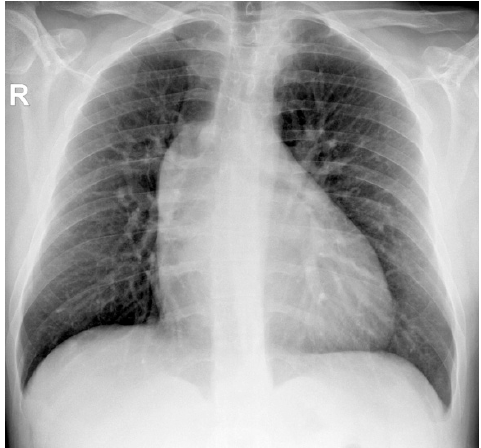
Figure 2. Thoracic radiography (AP projection)—widening of the middle mediastinum on the right (R); dextroconvex dorsal scoliosis.